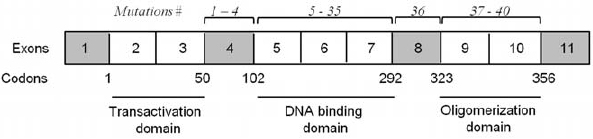
Figure 3. Schematic representation of P53 protein. Its 3 domains and corresponding coding exons are represented. Mutations of Table